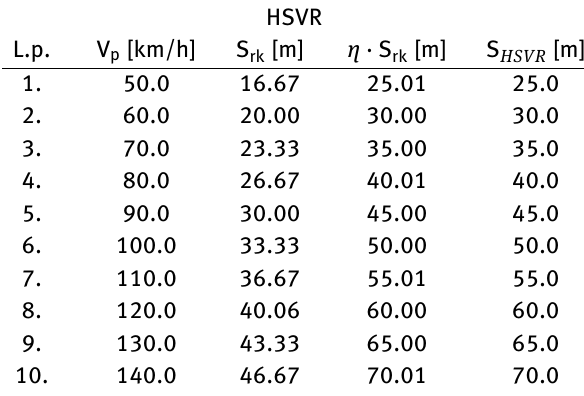
Table 2: Values: distance traveled during the driver’s reaction (t rk = 1.2 s), minimal distance between vehicles, depending on the speed of the car, for a safety factor η = 1.5 and according to